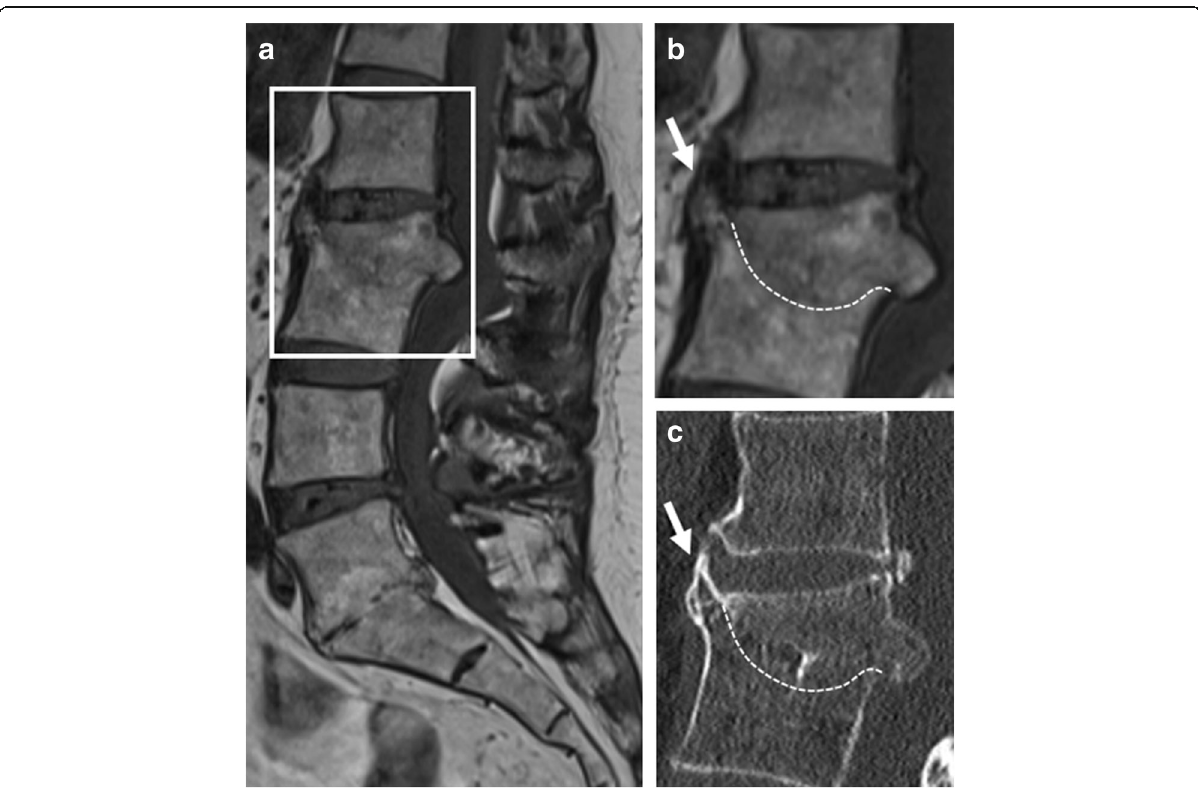
Fig. 12 Pitfalls in imaging and diagnosis of new bone formation: sequelae of infectious spondylodiscitis. a , b Sagittal T1-weighted MR images and ( c ) computed tomography (CT) show vertebral fusion (dotted line) of L2-L3 after destruction of the vertebrae and intervertebral disc due to tuberculous spondylodiscitis. Note that the protrusion of the remainder of the anterior corner of the L3 mimics plump syndesmophyte formation (short arrow). L5-S1 also shows signs of vertebral fusion after destruction of the intervertebral disc, mimicking transdiscal ankylosis as seen in SpA